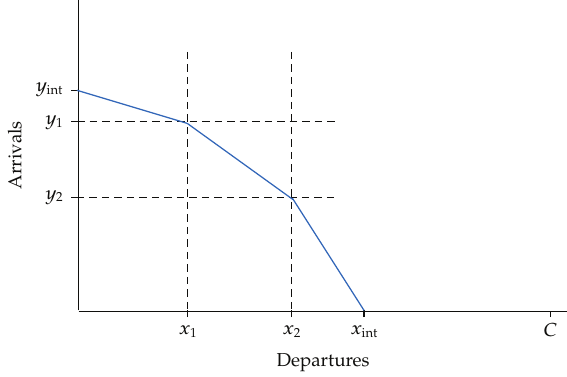
Figure 11: Step 4: the final piecewise linear segment is